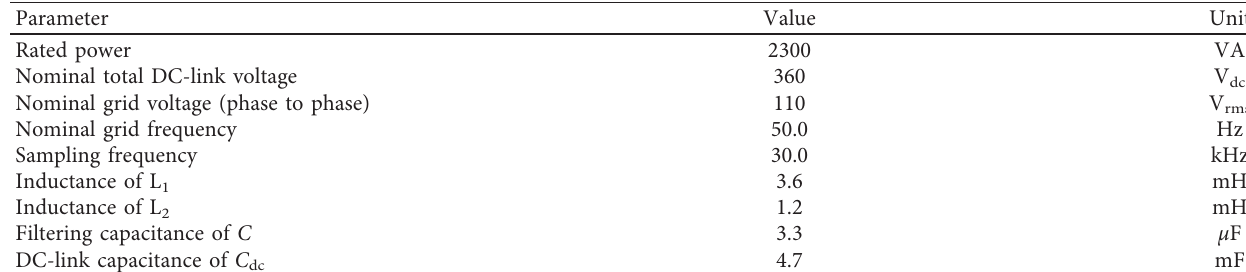
Figure 7: Simulation model diagram of PCS based on MATLAB/Simulink. Table 2: Main electric parameters for the simulation model of